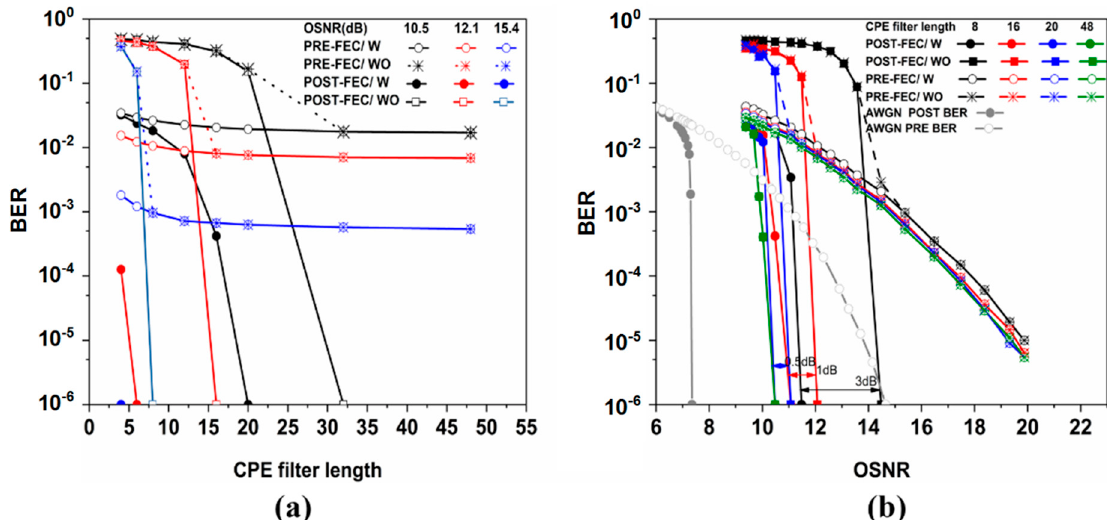
Figure 6. ( a ) BER versus CPE filter length curves of CPE and CPE + PAPU, with OSNR equivalent to 10.5 dB, 12.1 dB, and 15.4 dB; ( b ) BER versus OSNR curves of CPE and CPE + PAPU with different CPE filter lengths (W and WO respectively present the CPE +PAPU scheme and the CPE scheme).